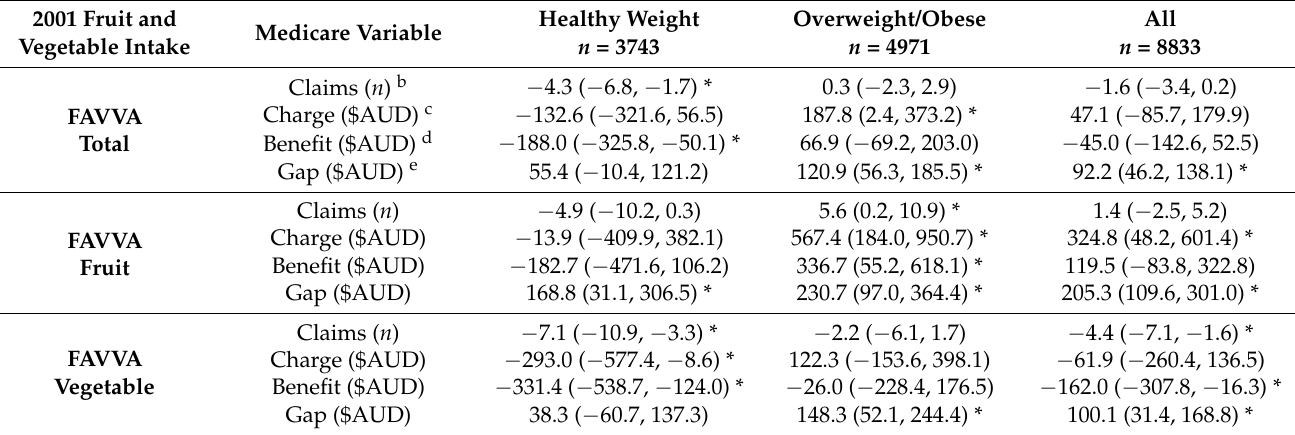
Table 3. Coefficients and 95% confidence intervals per 10-unit-higher baseline FAVVA as predictors of the 15-year (2001– 2015) cumulative Medicare claims and costs for Australian women born in 1946–1951 ( n = 8833) and within the baseline BMI category a